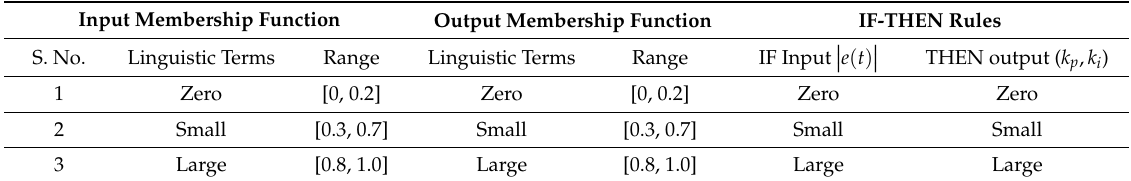
Table 2. IF-THEN rules for Fuzzy-PI and